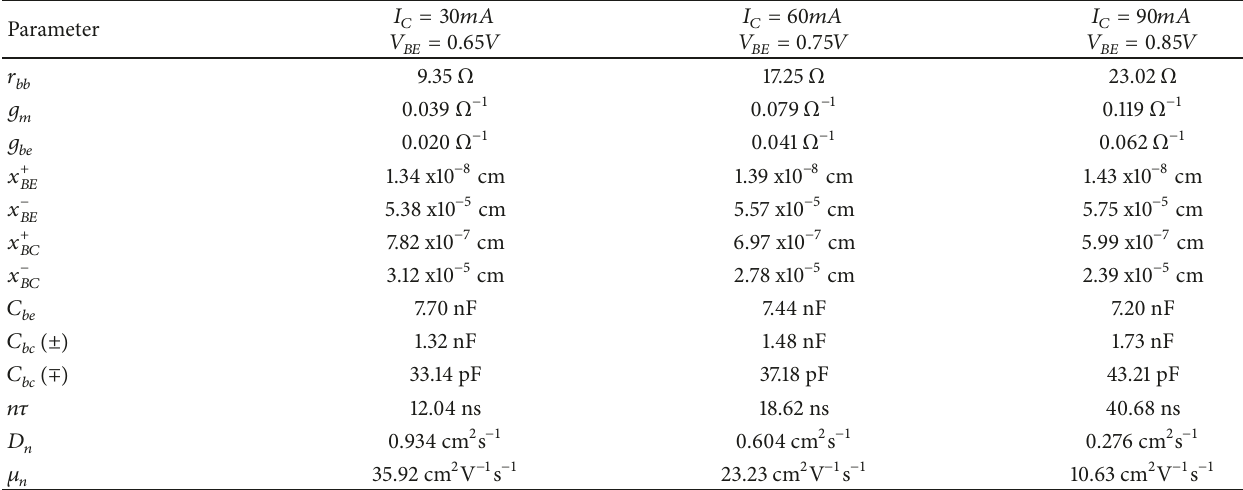
Table 1: Physical parameters for the NPN silicon MPSH10